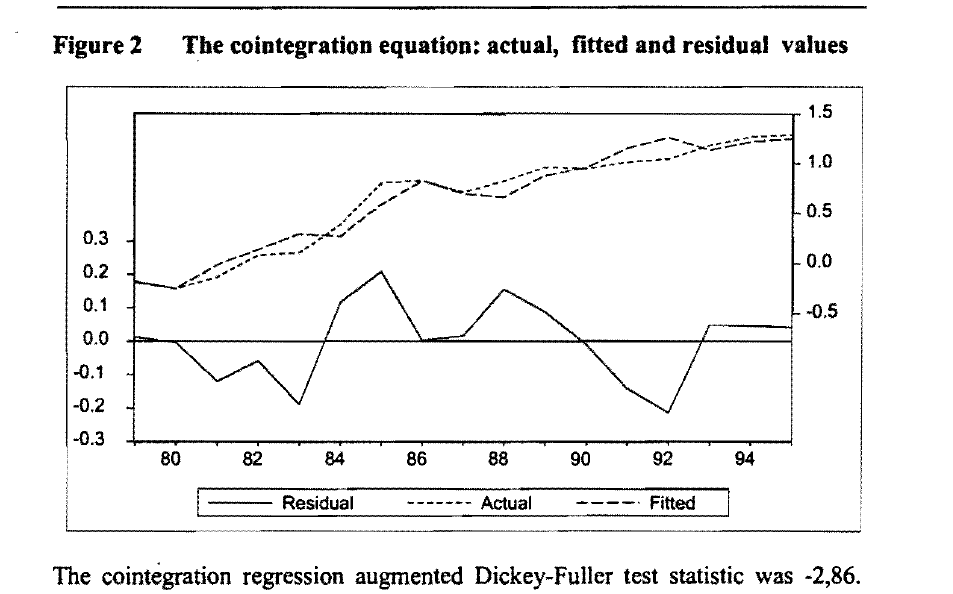
The cointegration equation: actual, fitted and residual